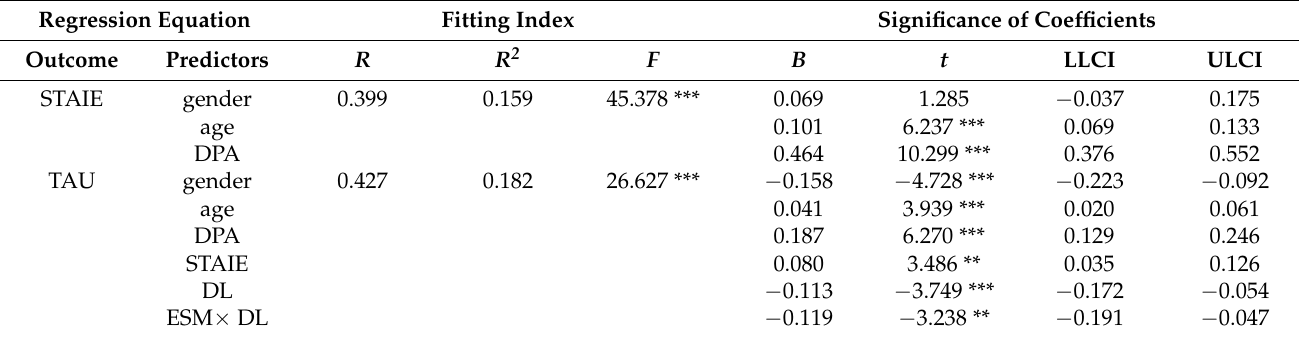
Table 2. Testing the moderated mediation model.